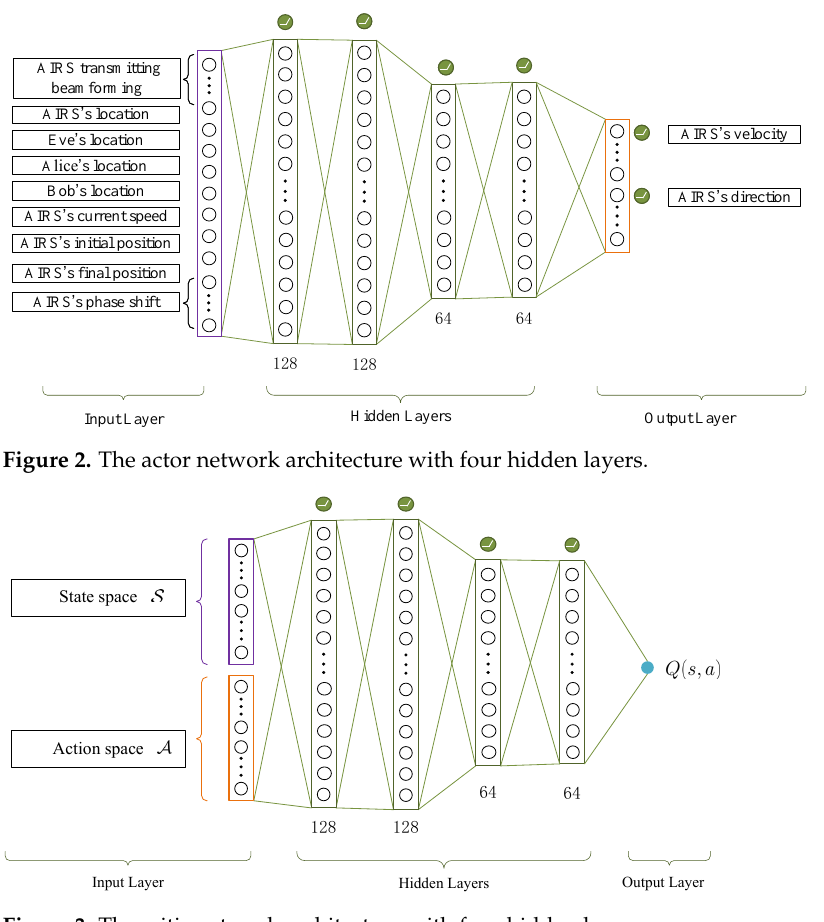
Figure 3. The critic network architecture with four hidden